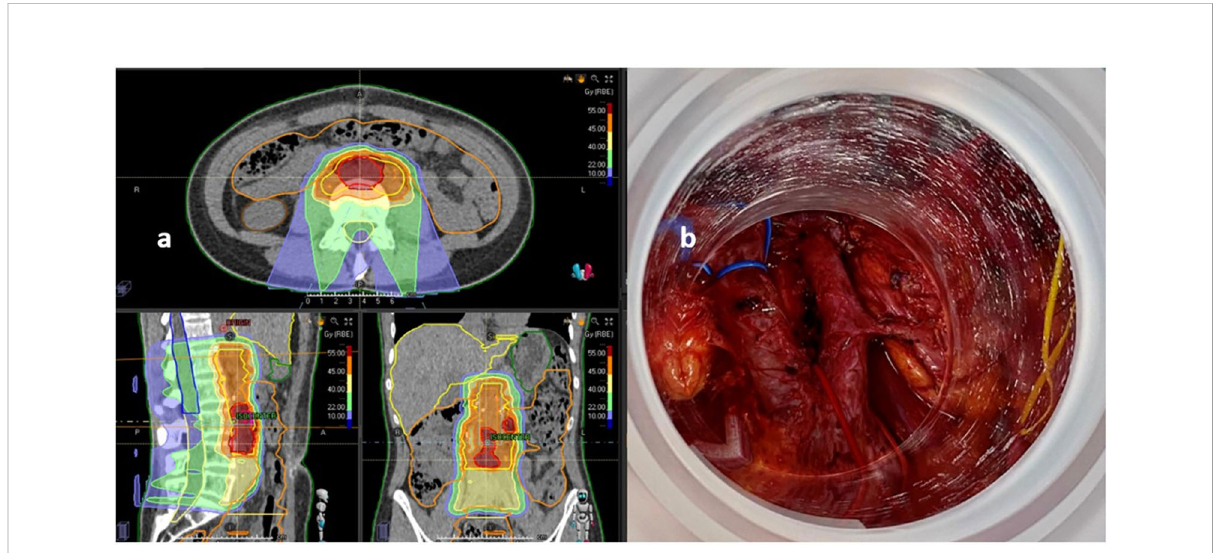
FIGURE 4 Recurrent cervix cancer patient treated with lymphadenectomy, IOeRT, and proton therapy after nodal oligo-progression outside the previous areas of external irradiation and brachytherapy. (A) Proton therapy fi eld arrangements and dose-distributions. (B) Beam ’ s eye view of the IOeRT target (notice the absence of dose-sensitive tissues such as bowel and